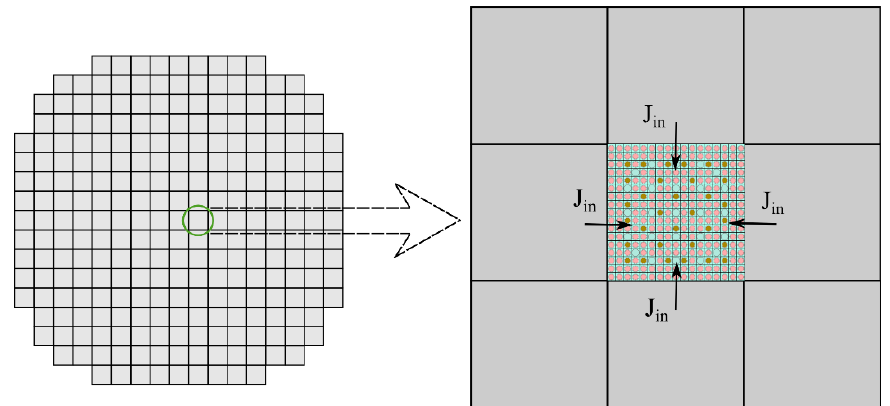
Figure 4. The multiscaling scheme for the smart, high-fidelity coupled core simulation for industrial applications using one resolved region that provides pin-level data, while the rest of the core is calculated based on the nodal resolution and approximations.